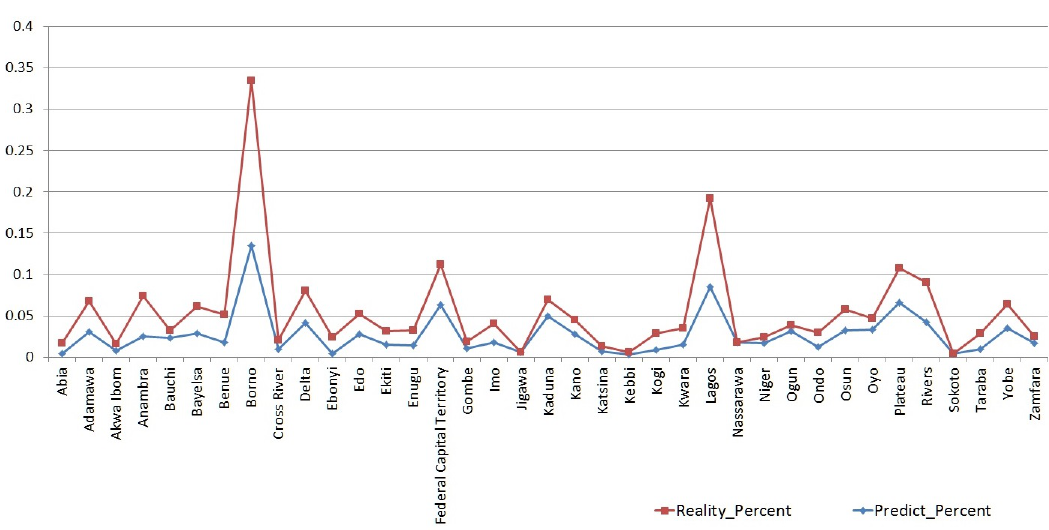
Figure 11. Comparison between the ratios of the event-issued frequencies.